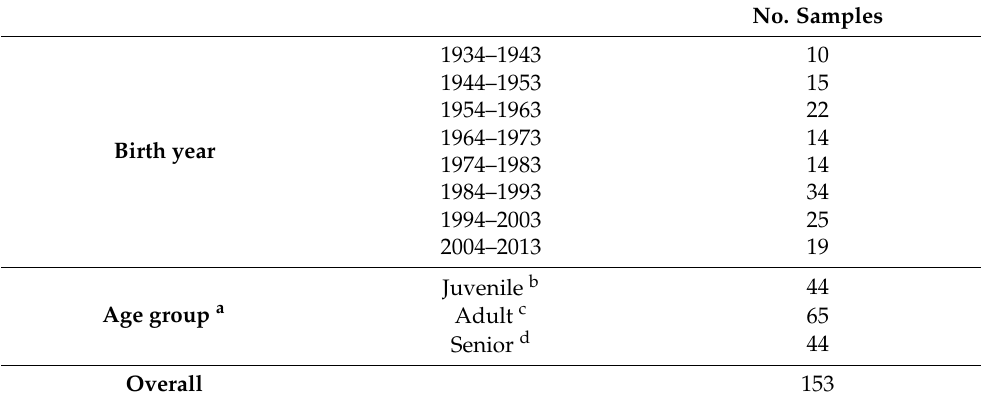
Table 1. Study serum sample age distribution shown by decade of birth ( n = 8) and age group ( n = 3).